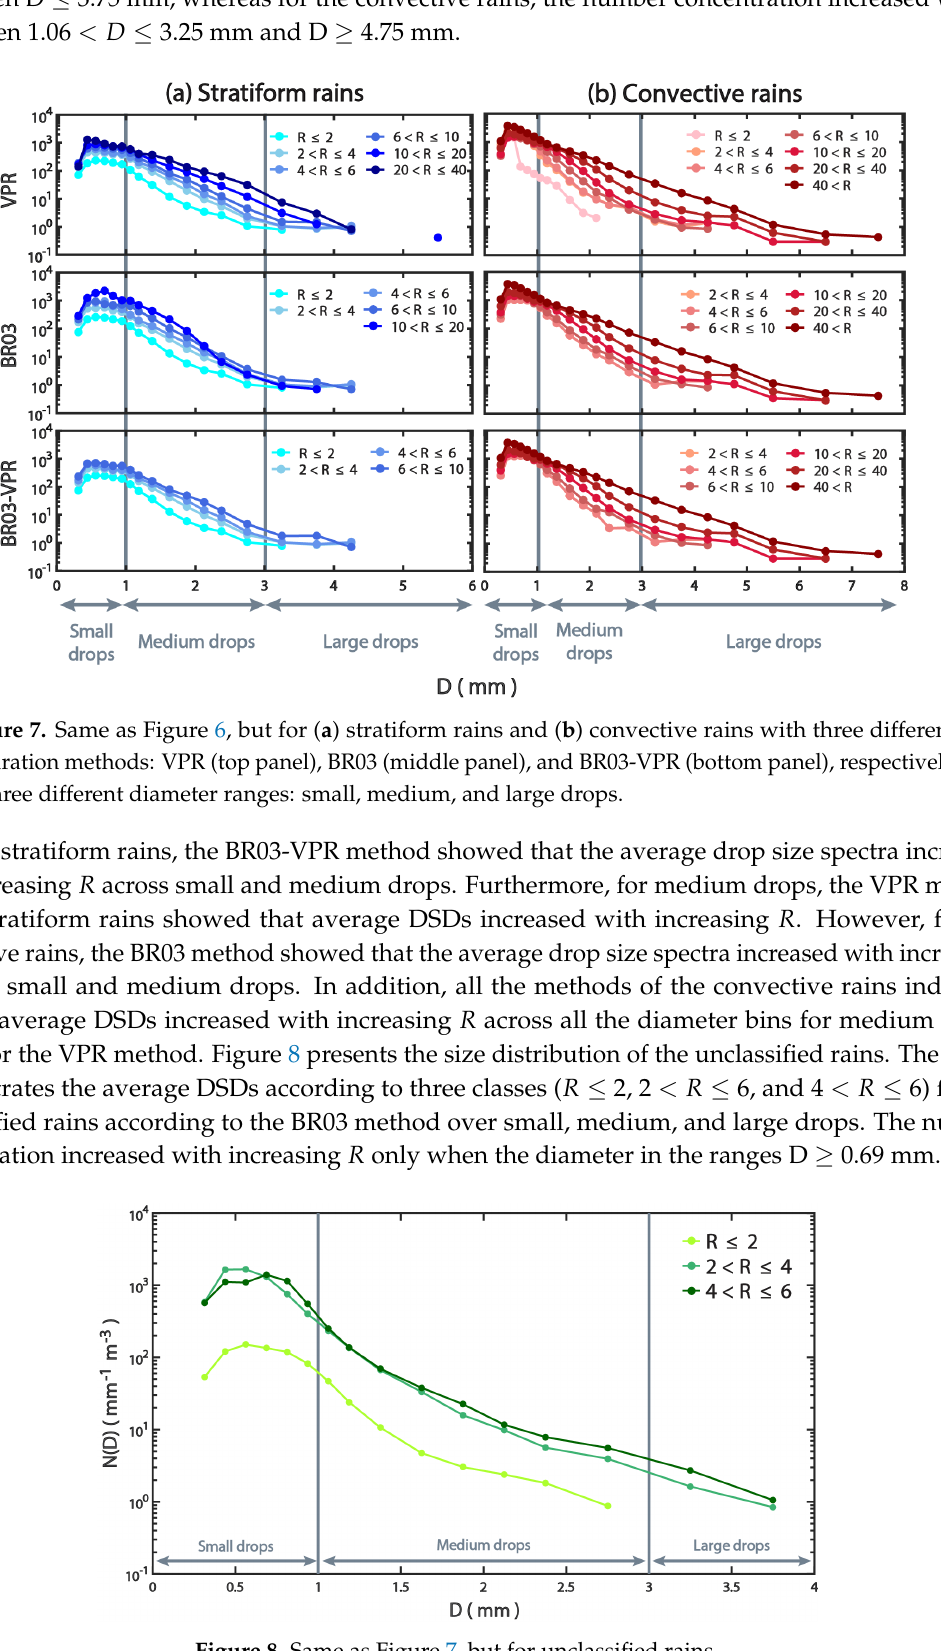
Figure 8. Same as Figure 7, but for unclassified